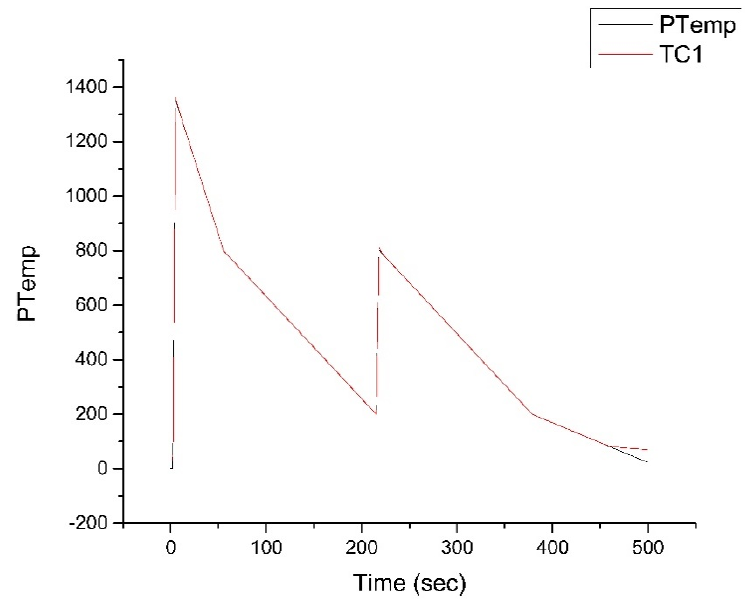
Figure 3. Thermal cycles simulating two welding passes to generate the IC CGHAZ zone. These thermal cycles were designed to obtain the microstructure of a heat affected zone (HAZ) from two welding passes. The first pass reaches a coarse-grained heat